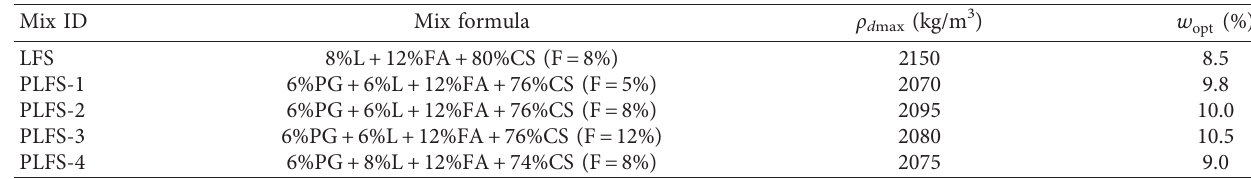
Figure 3: Schematic diagram of the shrinkage test. Table 2: Mix proportions of different materials and the compaction test